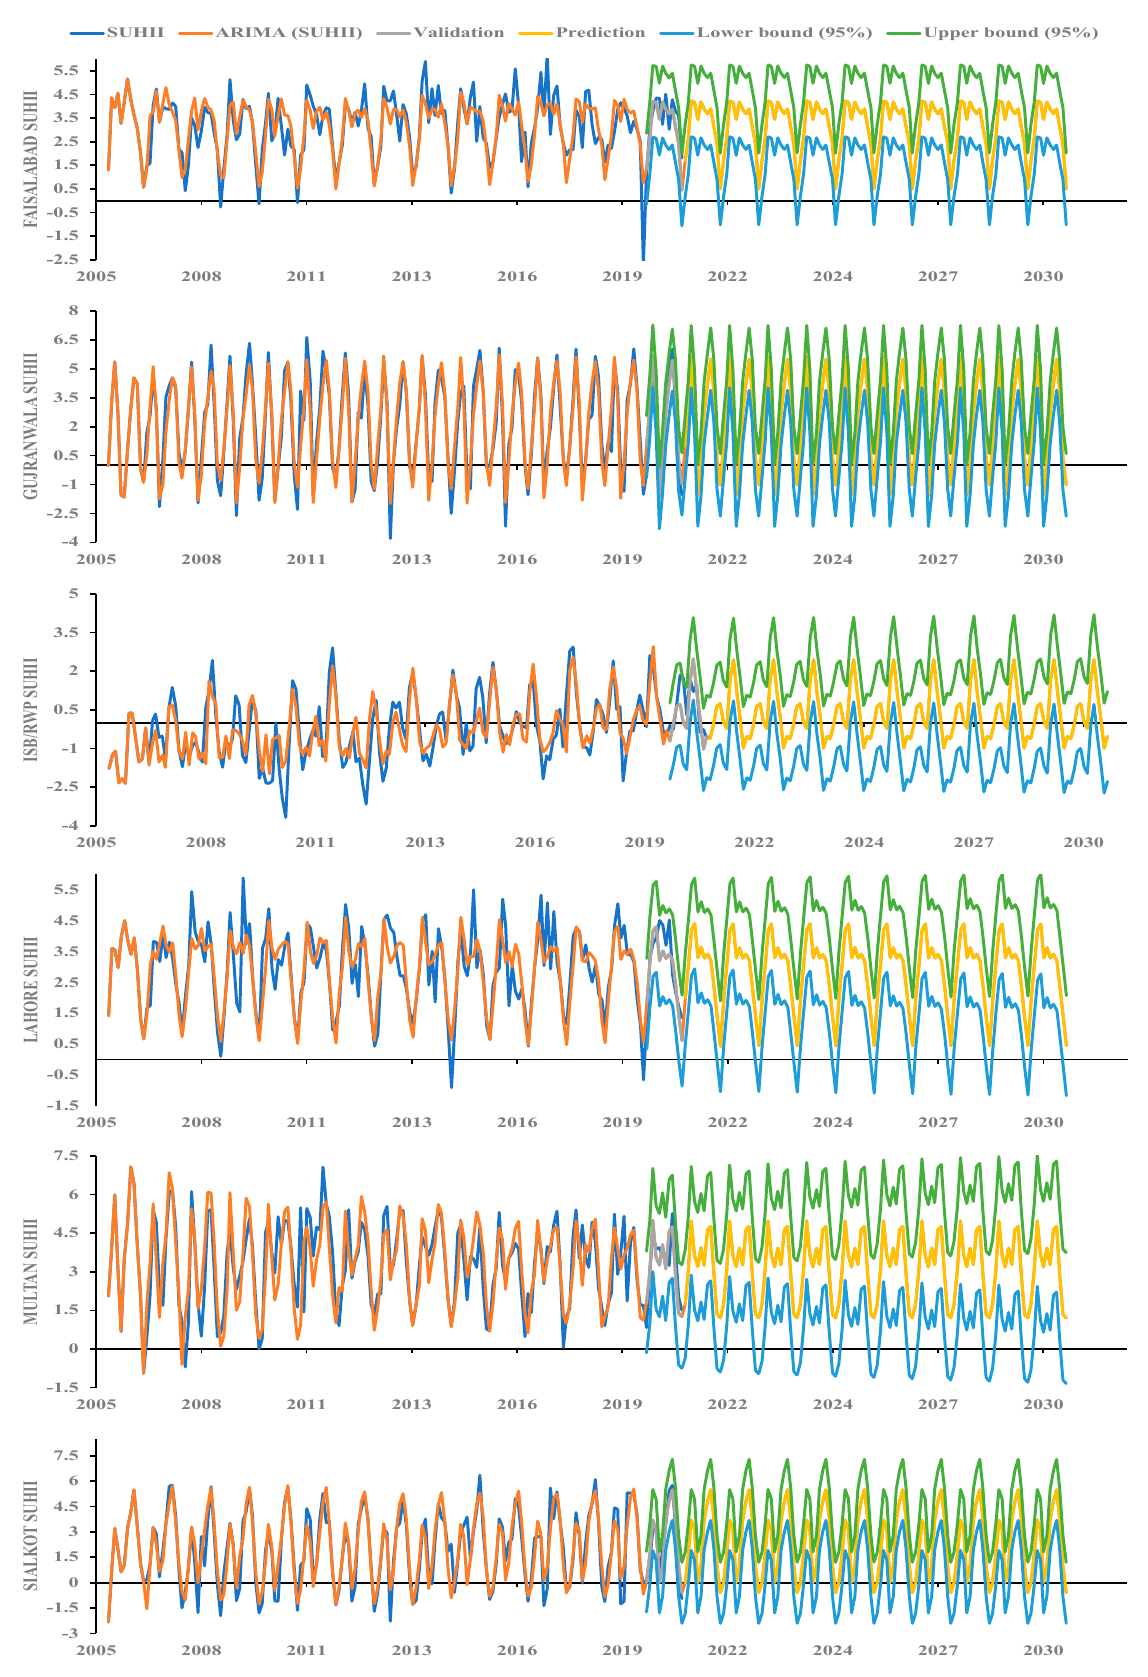
Figure 6. Forecasting for daytime SUHII by best fitted ARIMA .